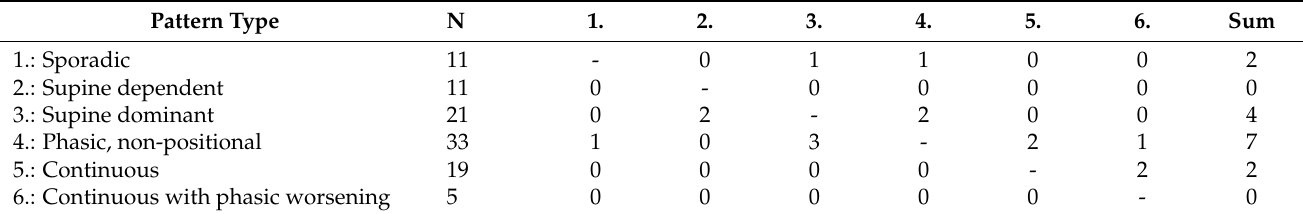
Table 5. Distribution and change of the patterns of the examinations (Total: 100).